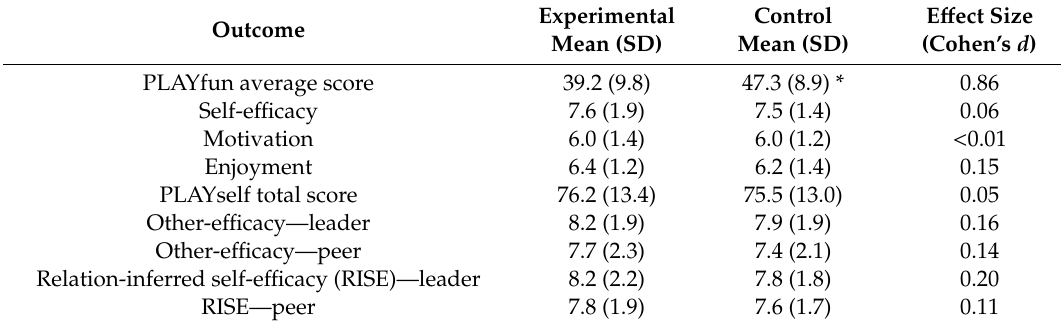
Table 4. Baseline scores, by group, on all child-level outcomes.